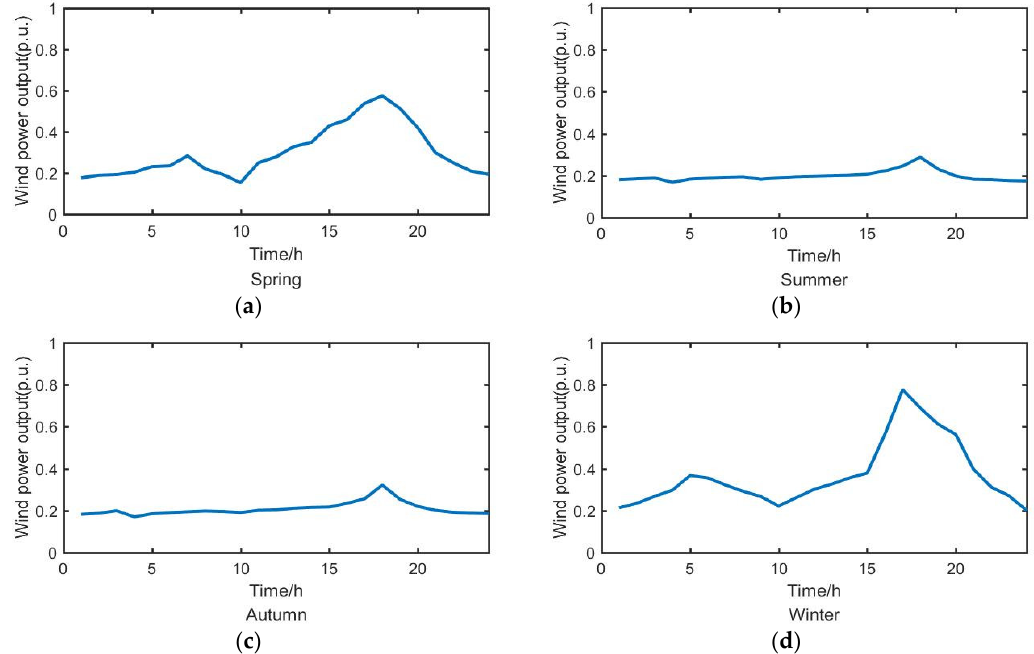
Figure 2. Wind power output fluctuation curve: ( a ) Wind power fluctuation curve in spring; ( b ) Wind power fluctuation curve in summer; ( c ) Wind power fluctuation curve in autumn; ( d ) Wind power fluctuation curve in winter.